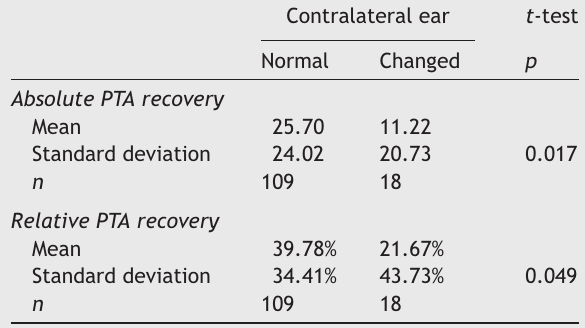
Independent Student’s t -tests between contralat- eral ear hearing states for recovery rates.